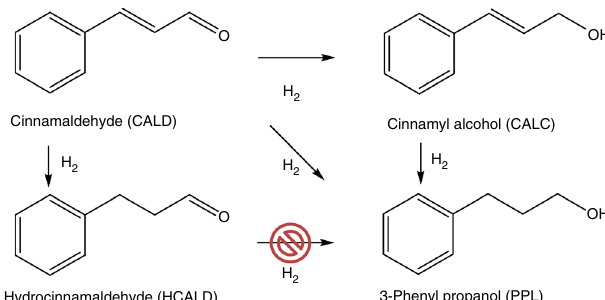
Fig. 2 Reaction scheme for the hydrogenation of cinnamaldehyde. Reaction pathways for CALD hydrogenation as observed for Pd/C catalysts at 80 °C,